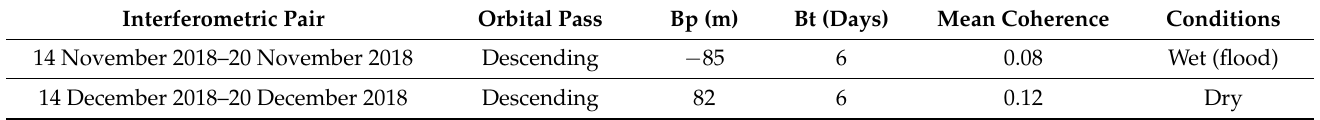
Table 4. Parameters of interferometric pairs selected for the flood impact on the coherence degradation analysis. Bp is the perpendicular baseline; Bt is the temporal